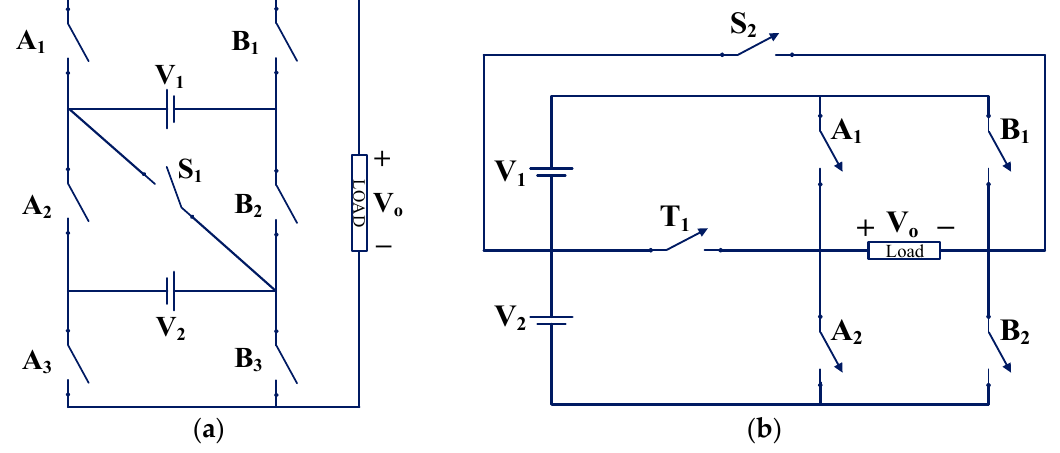
Figure 4. ( a ) Single-phase five-level modified CCS-MLI with fault tolerance capability (TP1) [28]. ( b ) Single-phase five-level modified T-type inverter with fault tolerance capability (TP2) [28]. ( b ) Single-phase five-level modified T-type inverter with fault tolerance capability (TP2)